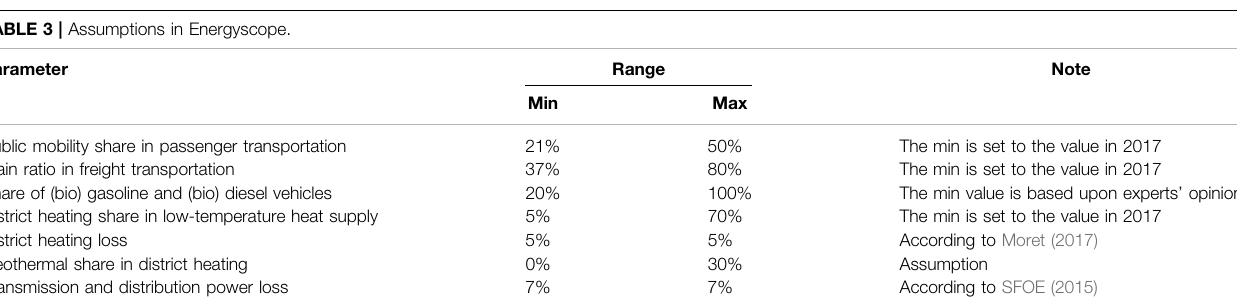
TABLE 3 | Assumptions in